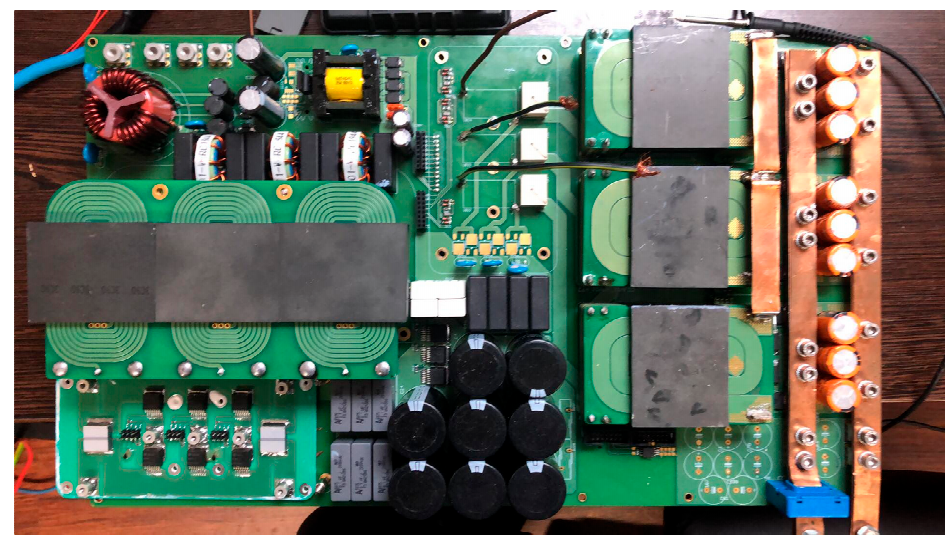
Figure 3. Physical prototype of experimental sample of proposed 3-phase PFC converter. Driver Selection and Circuit Configuration